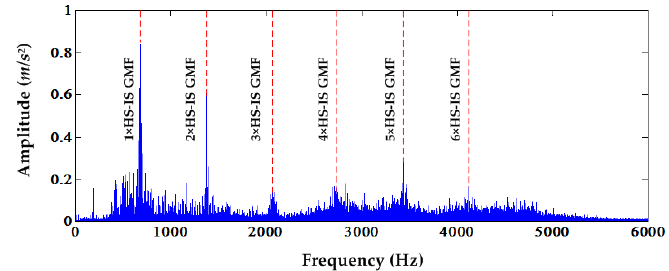
Figure 16. Frequency spectrum of the time synchronous signal